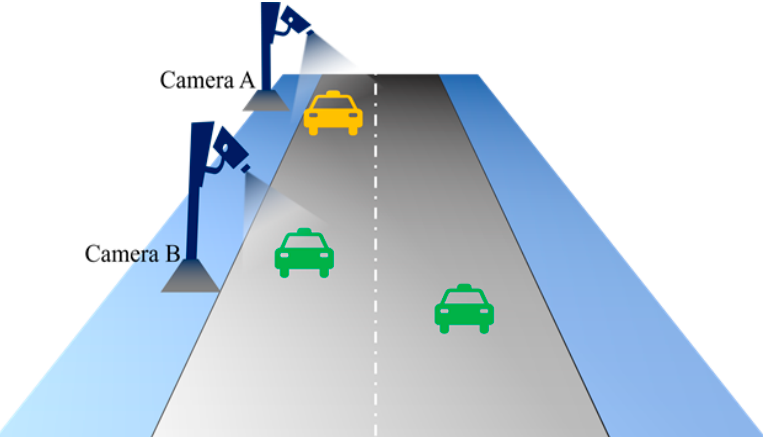
Figure 6. Illustrates the path of the vehicle between camera A and B.